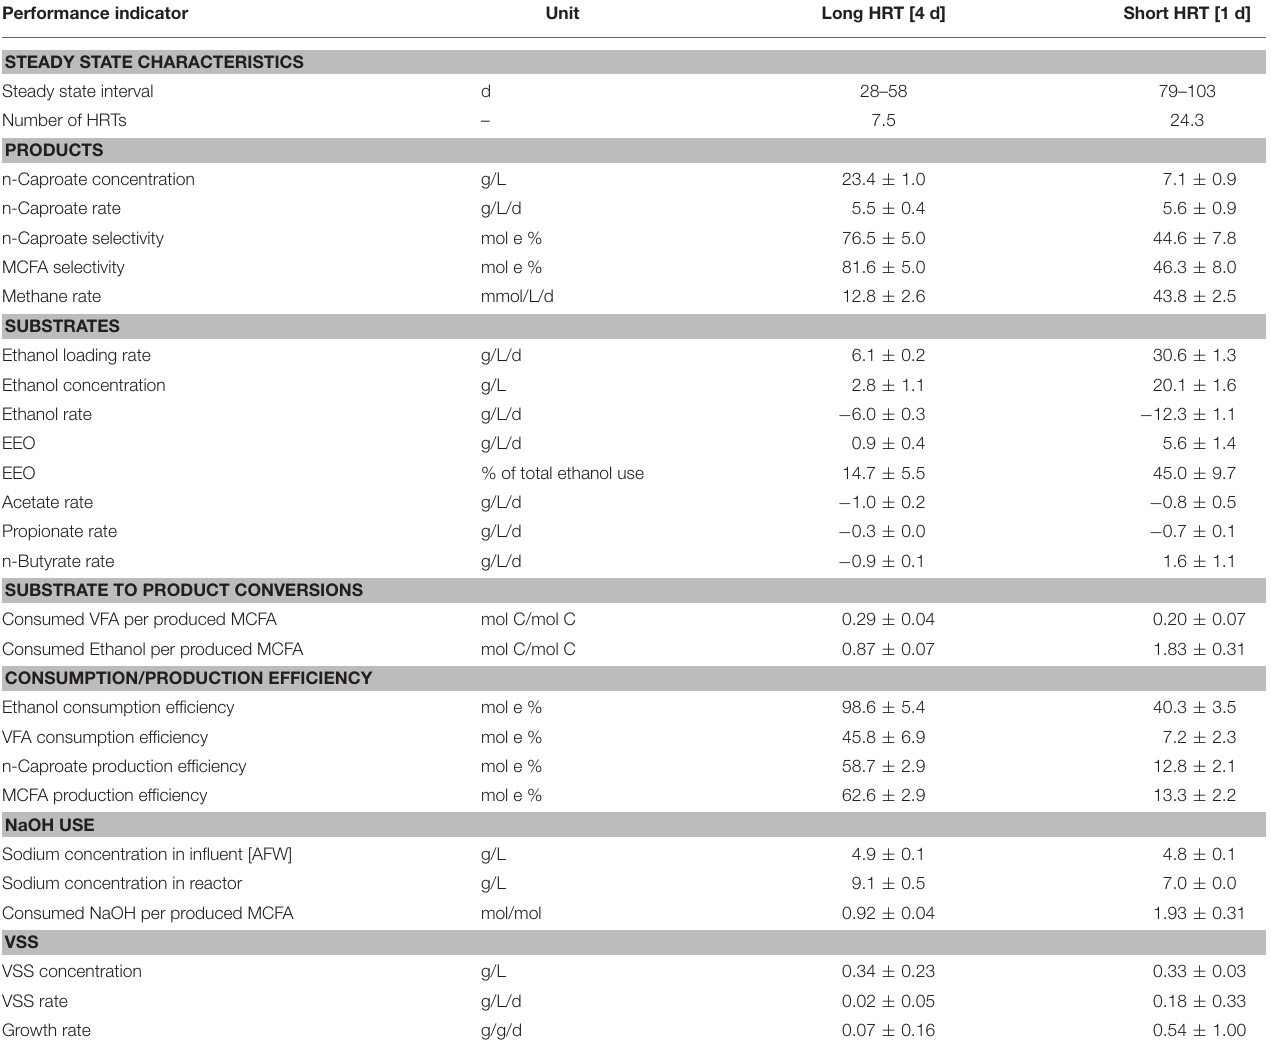
TABLE 1 | Performance indicators and properties of the chain elongation process at long and at short HRT. Performance